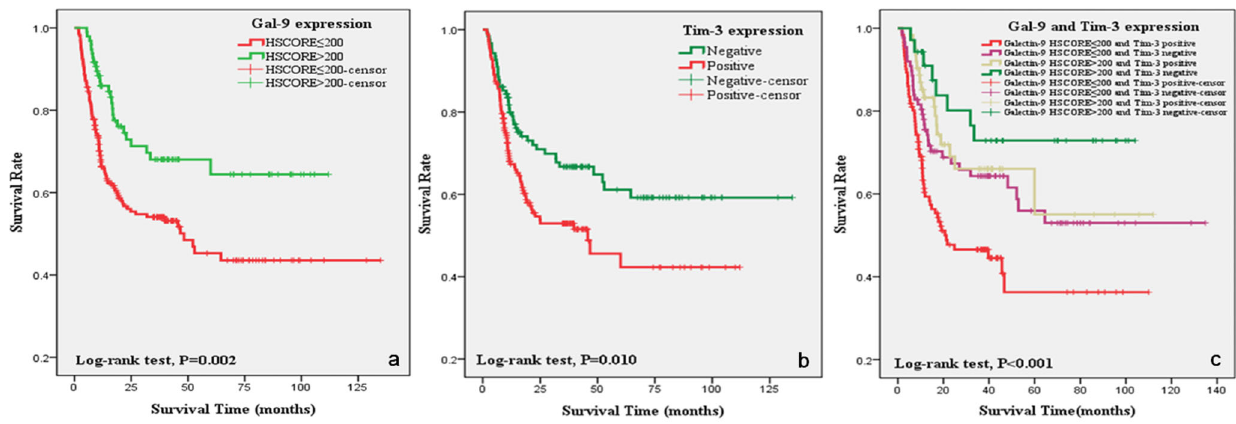
Figure 4. Multivariate analysis shows that high Gal-9 expression (4a), low Tim-3 expression(4b), and both Gal-9 HSCORE . 200 and Tim-3 negative expression (4c) were significantly associated with long overall survival in gastric cancer patients.